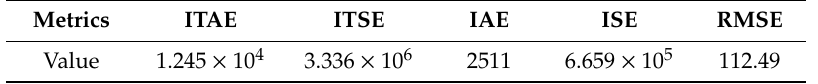
Table 14. Results for the FLC controller.